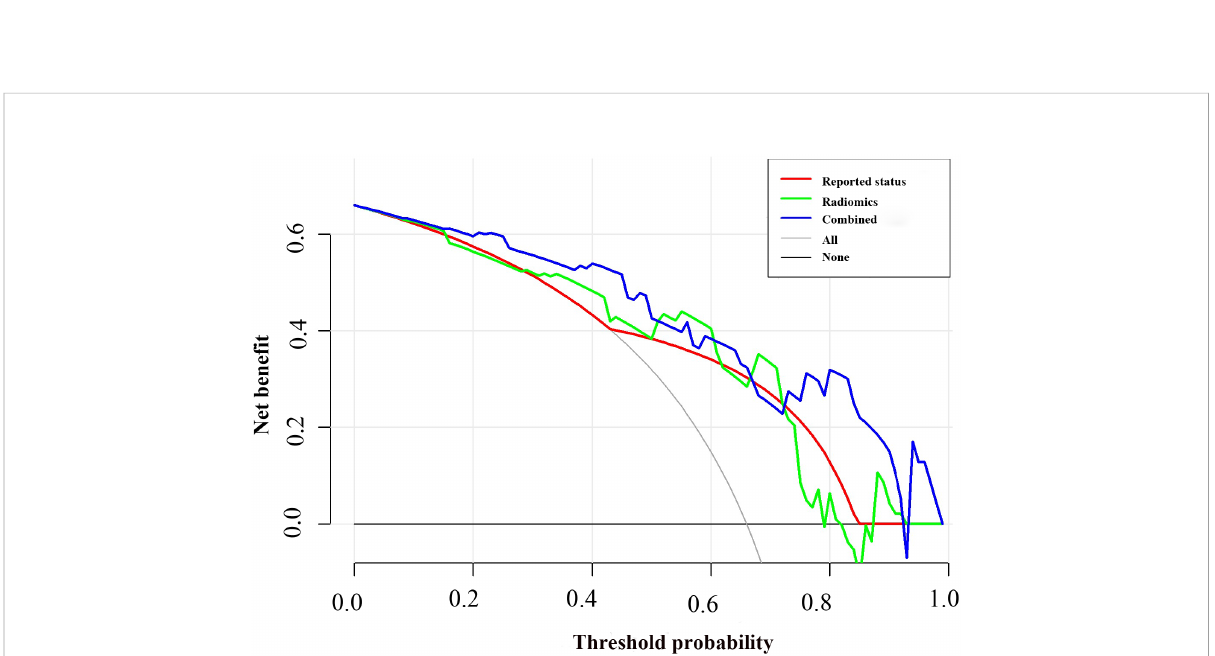
FIGURE 6 Decision curve analysis for the combined model compared with the radiomics model and reported status alone. The x-axis represented the threshold probability and the y-axis measured the net bene fi t. The blue line represented the combined model. The green line represented the radiomics model. The red line represented the MRI-reported status model. The grey line represented the assumption that all patients had lymph node (LN) metastasis. The black line represented the hypothesis that no patients had LN